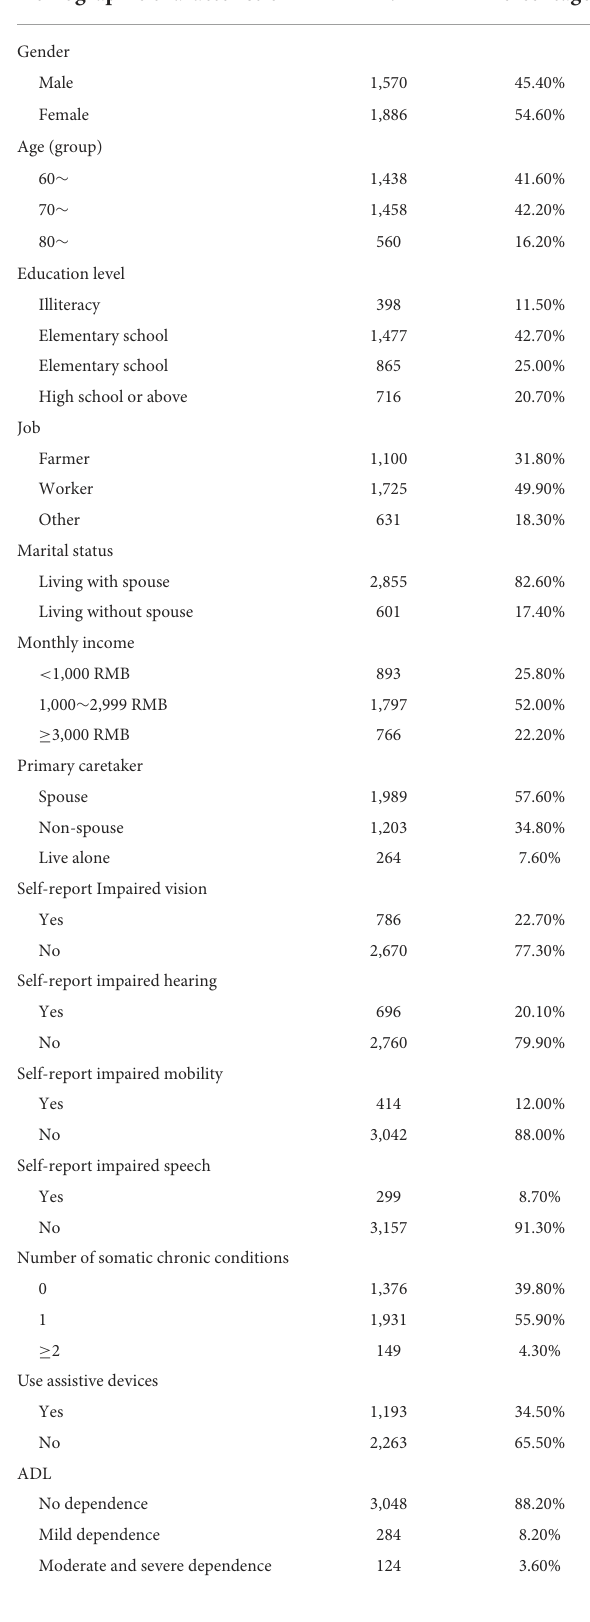
TABLE 1 Descriptive characteristics of the participants ( n =